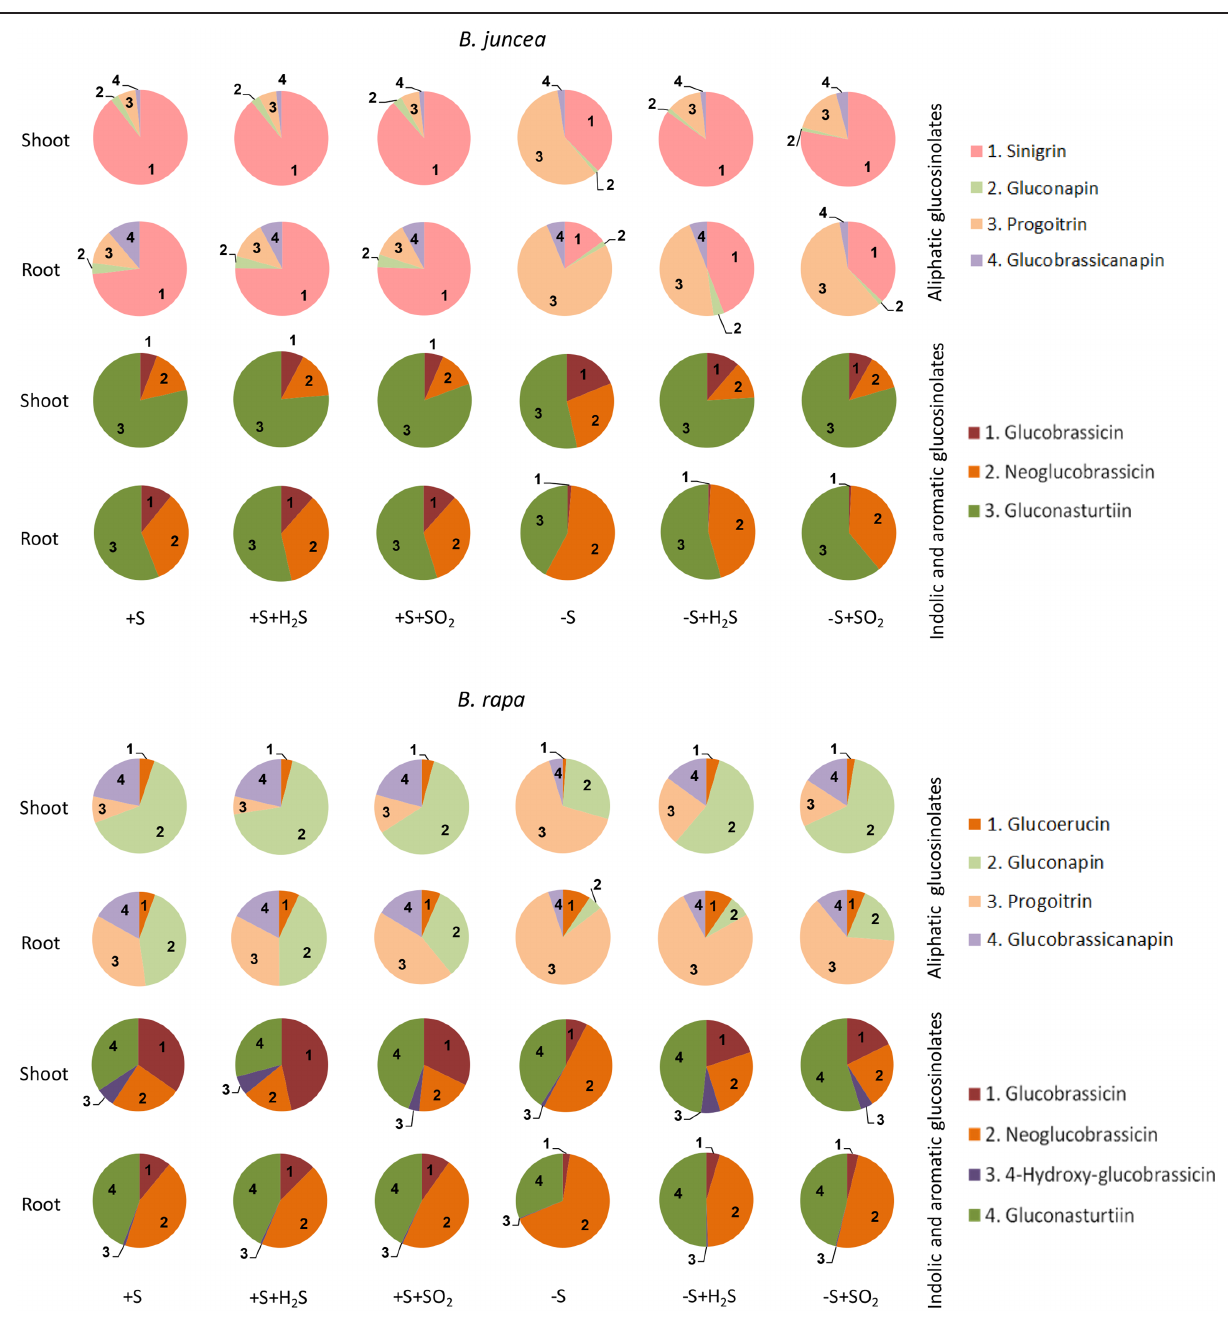
FIGURE 2 | Impact of H 2 S and SO 2 and sulfate deprivation on the composition of glucosinolates in shoots and roots of B. juncea and B. rapa . For experimental details, see legends of Figure 1 . The pie graphs represent the composition of the glucosinolates (for details on their nomenclature see Table 1 ), the absolute data are presented in Figures 3 and 4